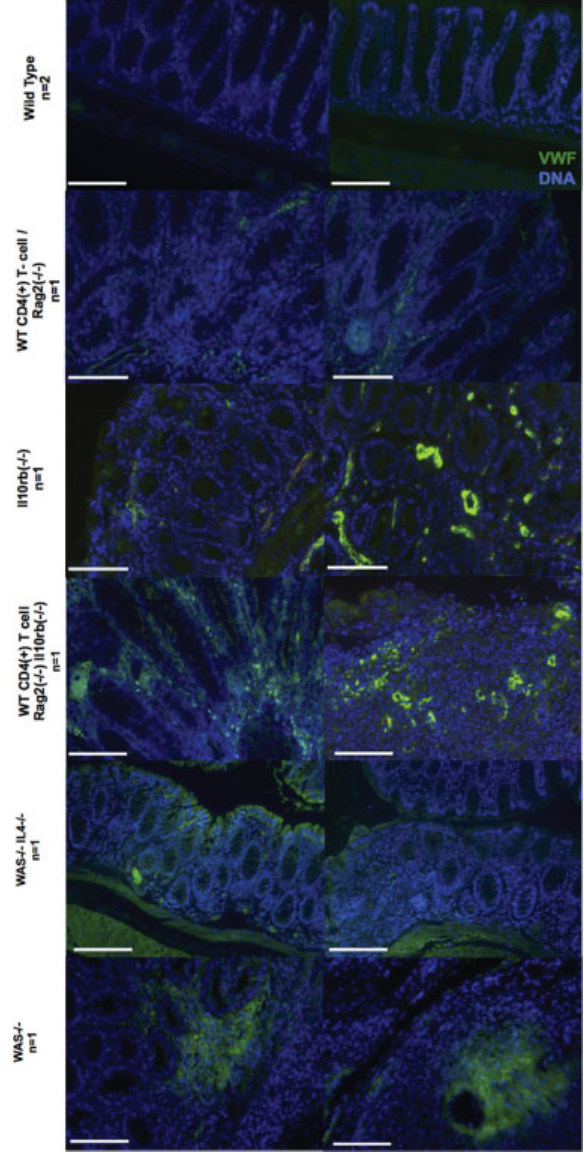
Fig. 4 MousemodelsofchroniccolitisshowsignsofVWFreleaseinaffected colonic tissue with anti-VWF fl uorescent staining. WT mice colon tissue sections (top) stained for VWF (green) and DNA (blue) show minimal VWF- positivestainingwithfaintexpressionwithinvesselwalls.Colonsectionsfrom T cell transfer and chronic colitis models showed increased VWF staining dependent on the severity of the phenotype. WT CD4( þ ) T cell transfer into Rag2 (cid:1) / (cid:1) and Il10rb (cid:1) / (cid:1) mice has a less severe phenotype and show less